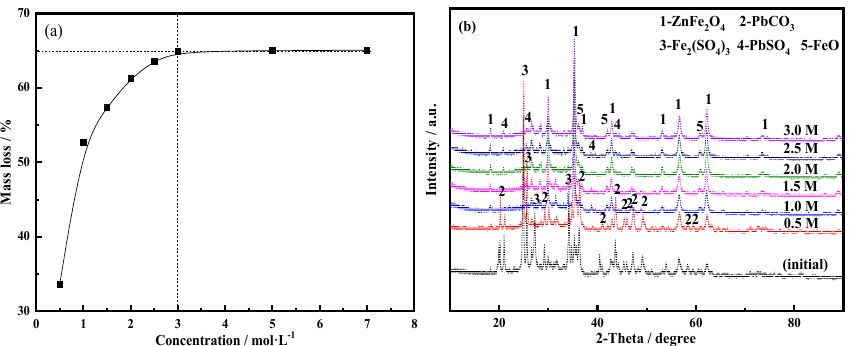
Figure 11. Mass loss and XRD pattern of pickling residue with different concentrations of acetic acid; ( a )-mass loss; ( b )-XRD pattern (25 °C, liquid–solid ratio: 10 mL·g − 1 , stirring speed: 400 r·min − 1 , dissolution time: 90 min).